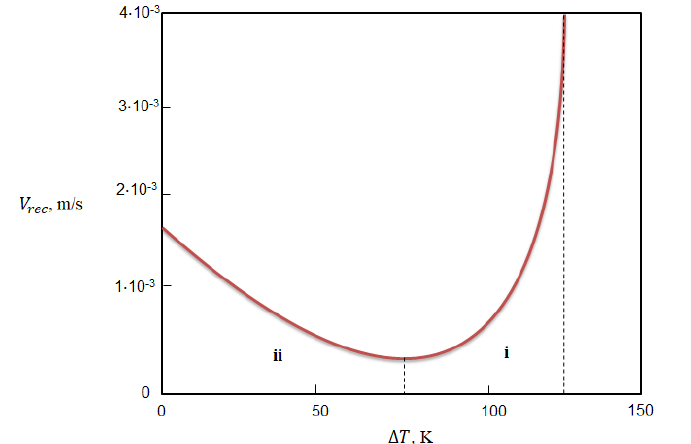
Figure 4. The recalescence front velocity V rec as a function of melt undercooling ∆ T . Region (i) describes predominant crystal growth in comparison to the nucleation of crystals ahead of the phase interface while Region (ii) corresponds to propagation of the recalescence front due to predominant contribution of nucleation of crystals over their growth (with the attachment of crystals to the phase interface). Physical parameters used for calculations correspond to Figure 3 and l = 1, µ k = 5 · 10 − 6 m s − 1 K − 1